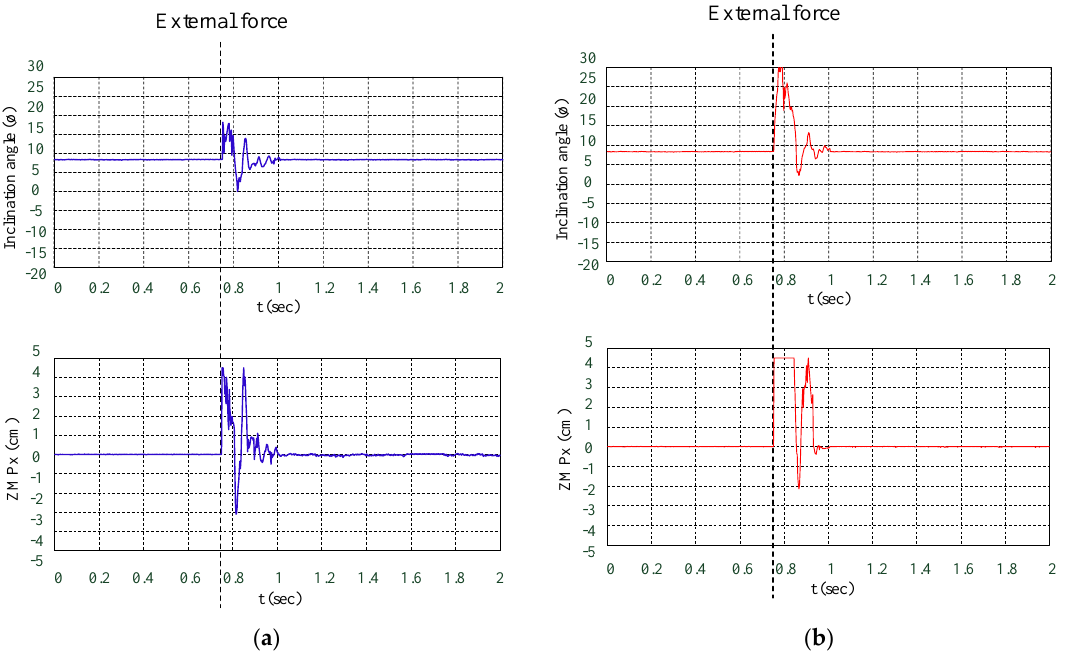
Figure 14. Experimental results of the TKU-X robot hit from the back by a baseball or a volleyball at 0.75 s when the balance control method is enabled. ( a ) Baseball. ( b ) Volleyball. Table 5. Experimental result of the proposed method with the stepping forward is enabled and disabled.